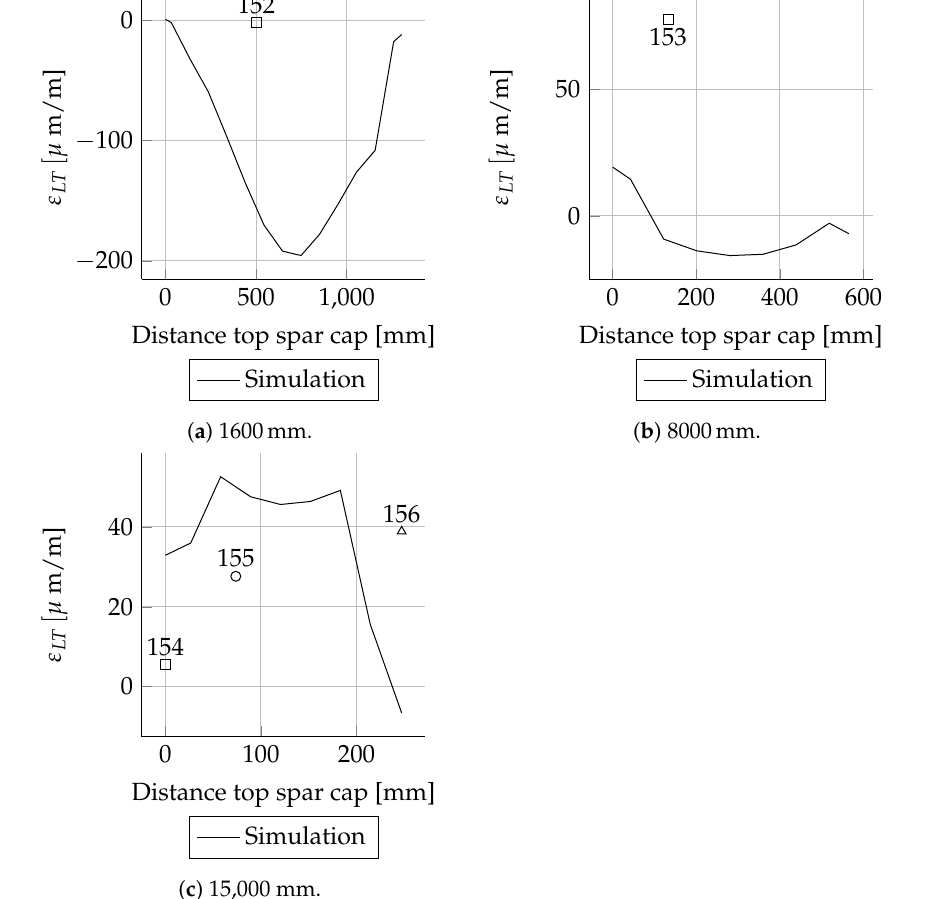
Figure A14. Spar at shear strains for Mxmax load